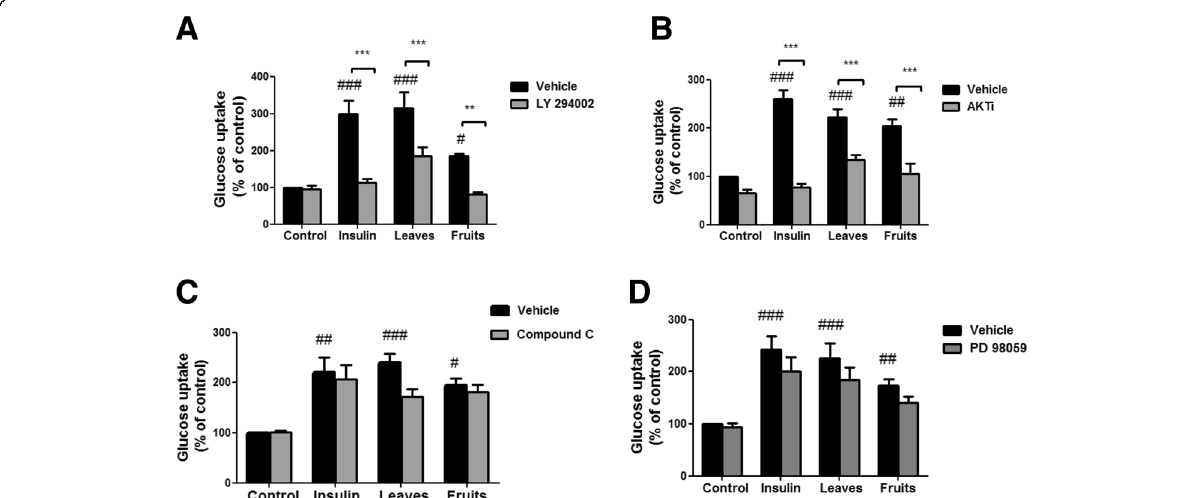
Fig. 5 Glucose uptake induced by aerial parts of S. spinosum is mediated by PI3K and Akt. Differentiated 3 T3-L1 adipocytes were treated with leaves and fruits (2 mg/ml) or roots (1 mg/ml) extracts, with the use of insulin (100 nM) as a positive control, in the presence or absence of LY294002 ( a ), AKT inhibitor VIII ( b ), compound C ( c ), or PD 98059 ( d ). The uptake of [3H]2-Deoxy-D-glucose into cells was determined as described in Materials and Methods . Data are expressed as percent of basal uptake in control cells. The data represents the mean ± SE of measurement made on three replicates in each of at least 4 independent experiments. # p < 0.05, ## p < 0.005, ### p < 0.0005 compared to untreated cells, ** p < 0.005, *** p < 0.0005 comparing cells treated with the indicated extract in the presence or absence of the indicated inhibitor, analyzed by one-way analysis of variance (ANOVA), followed by Bonferroni ’ s post-hoc